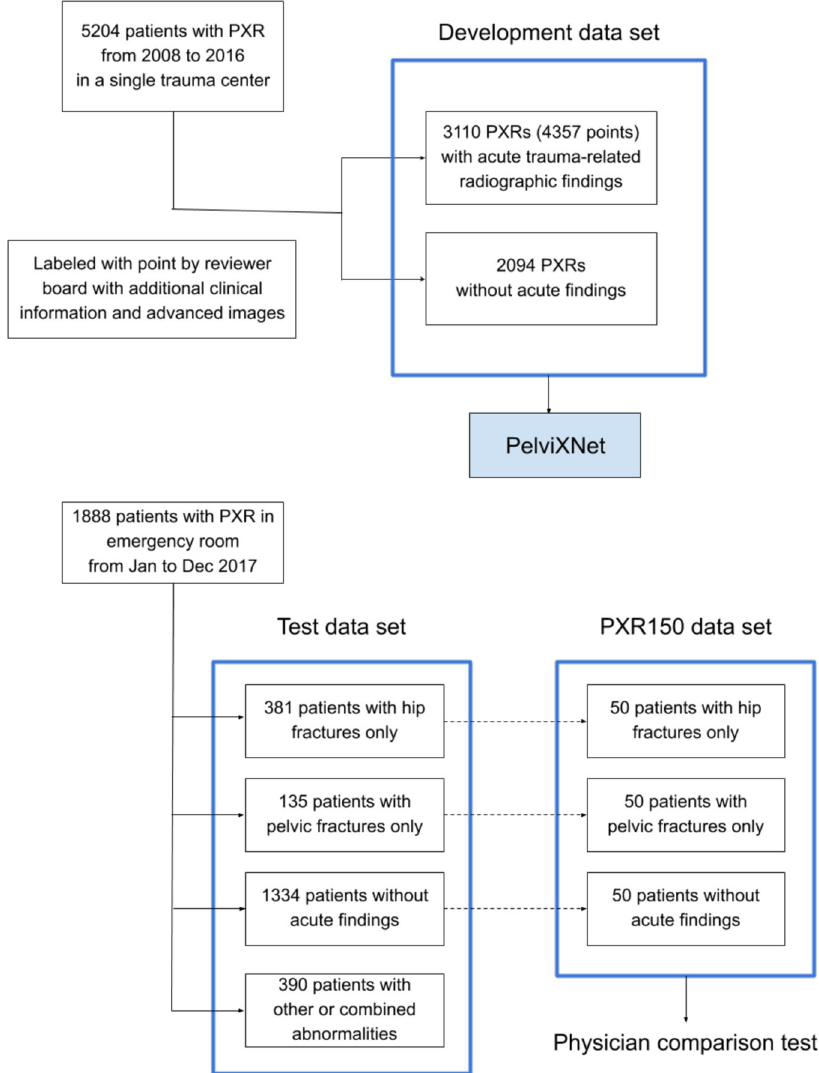
Fig. 1 The source and distribution of each data set. We included 5204 pelvic radiographs (PXR) from 2008 to 2016 as our development data set to develop PelviNet. Then we included PXRs from 1888 patients presented in the emergency room from January to December 2017 as our test data set. In advance, we randomized selected 150 PXRs from the test dataset to compose the PXR150 data set, which was used to perform the physician